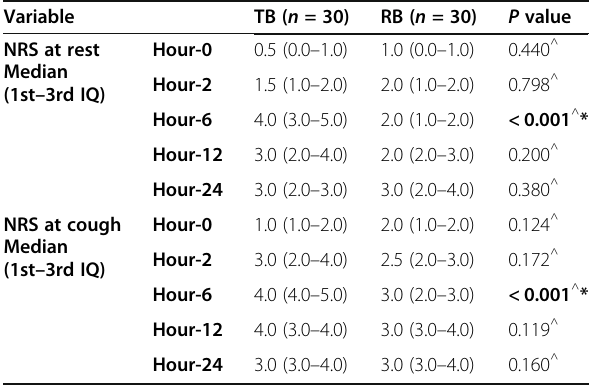
Table 2 Postoperative NRS scores among the study